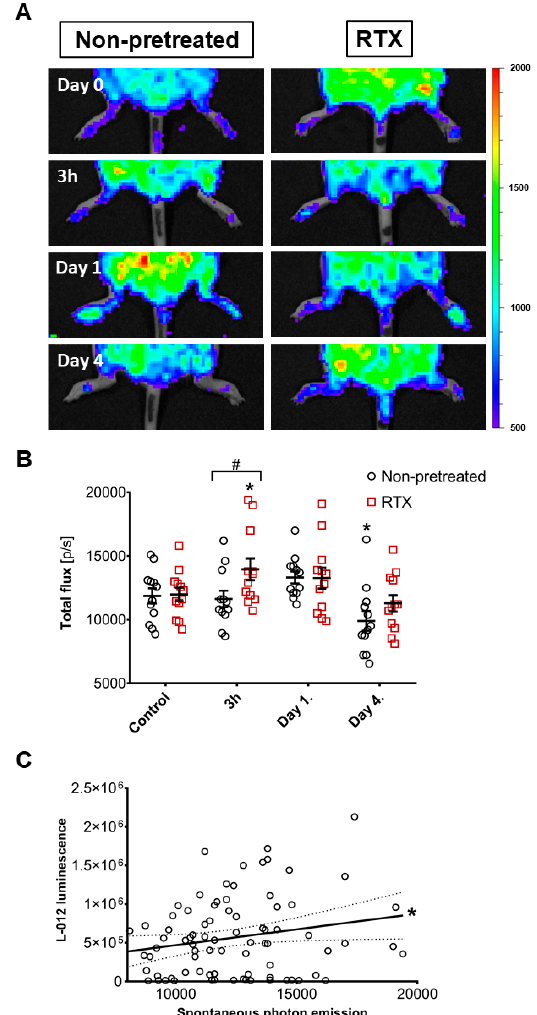
Figure 5. In vivo spontaneous ROS-derived photon emission. ( A ) Representative luminescence images, ( B ) Quantitative data. Individual values, means, ± SEM, two-way ANOVA and Fishers LSD test, n = 6/group, both hindlimbs. * p < 0.05, vs. self-control values before arthritis induction, # p < 0.05 vs. non-pretreated arthritic group. ( C ) Linear regression and correlation of the spontaneous photon signal and the L-012-derived luminescence. All matched data pairs shown from both non-pretreated and RTX-pretreated groups. * p < 0.05.